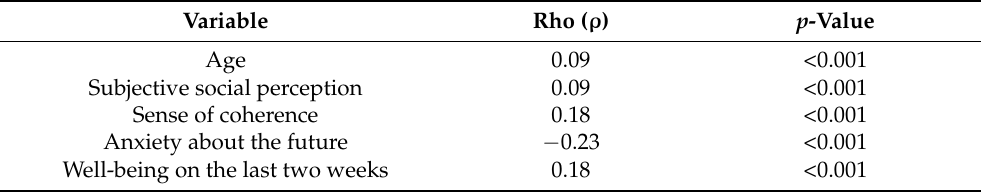
Table 4. Construct validity of the DHLI scale translated into Spanish with the Spearman correlation.